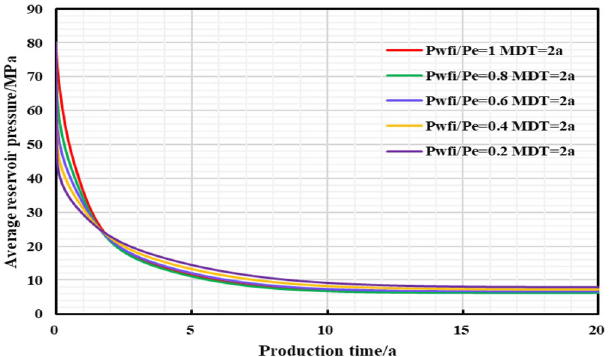
Figure 30. The relationship between average reservoir pressure and time under different initial controlled pressures.